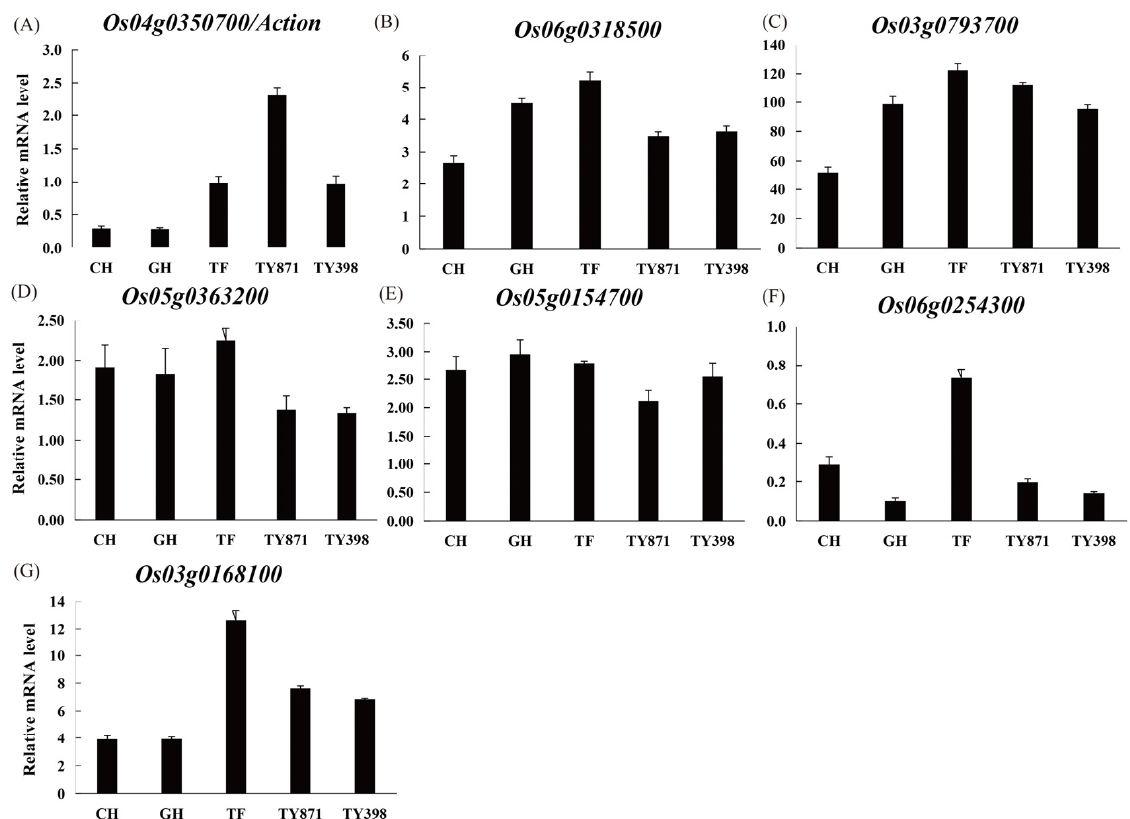
Figure 6. qRT-PCR validation of the seven genes from RNA-seq analysis. ( A ) Relative mRNA expression level of Os04g0350700 gene. ( B ) Relative mRNA expression level of Os06g0318500 gene. ( C ) Relative mRNA expression level of Os03g0793700 gene. ( D ) Relative mRNA expression level of Os05g0363200 gene. ( E ) Relative mRNA expression level of Os05g0154700 gene. ( F ) Relative mRNA expression level of Os06g0254300 gene. ( G ) Relative mRNA expression level of Os03g0168100 gene.